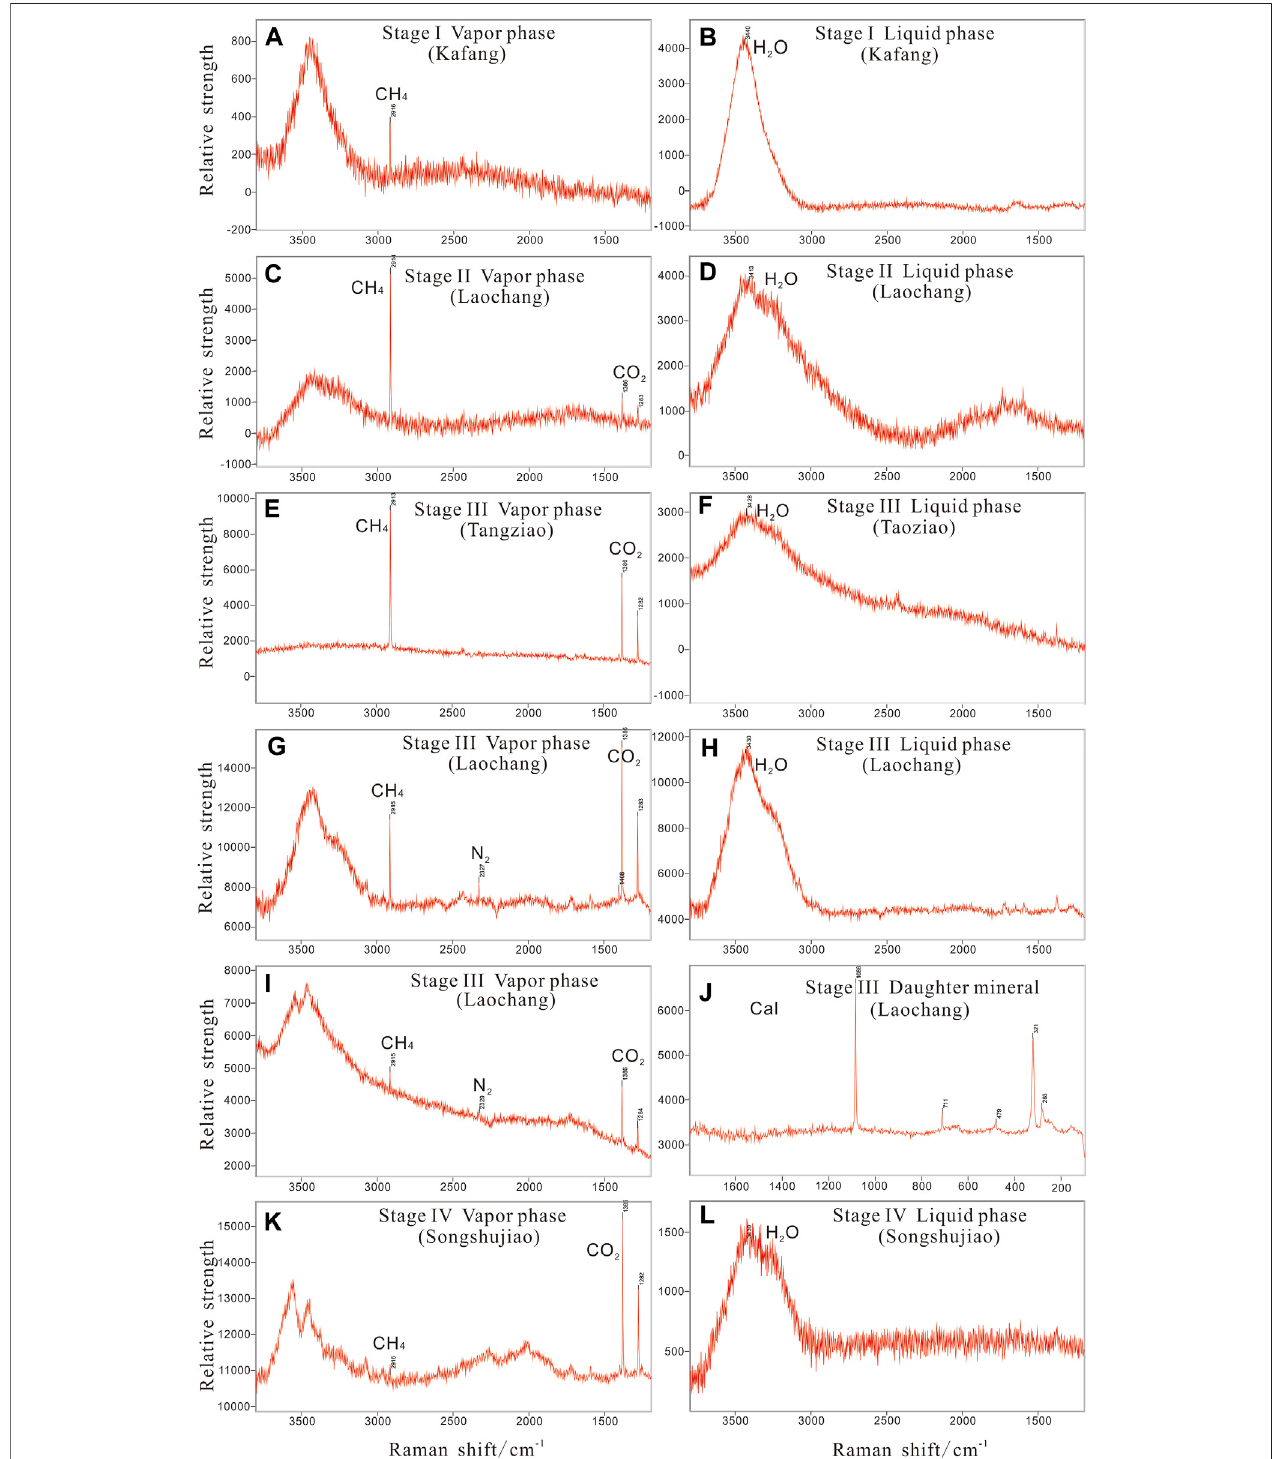
FIGURE 8 | Representative Raman spectra of fl uid inclusions in the Gejiu Sn – Cu polymetallic deposits. (A) Type – VL inclusion in stage I from Kafang. (B) Type – LV inclusion instage Ifrom Kafang. (C) Type – VL inclusion in stage II from Laochang. (D) Type – LV inclusion in stage IIfrom Laochang. (E) Type – VL inclusion in stage III from Tangziao. (F) Type – LVinclusioninstageIIIfrom Tangziao. (G) Type – VLinclusioninstageIIIfrom Laochang. (H) Type – LVinclusioninstageIII fromLaochang. (I) Type – VL inclusion in stage III from Laochang. (J) Type – US inclusion in stage III from Laochang. (K) Type – VL inclusion in stage IV from Songshujiao. (L) Type – LV inclusion in stage IV from